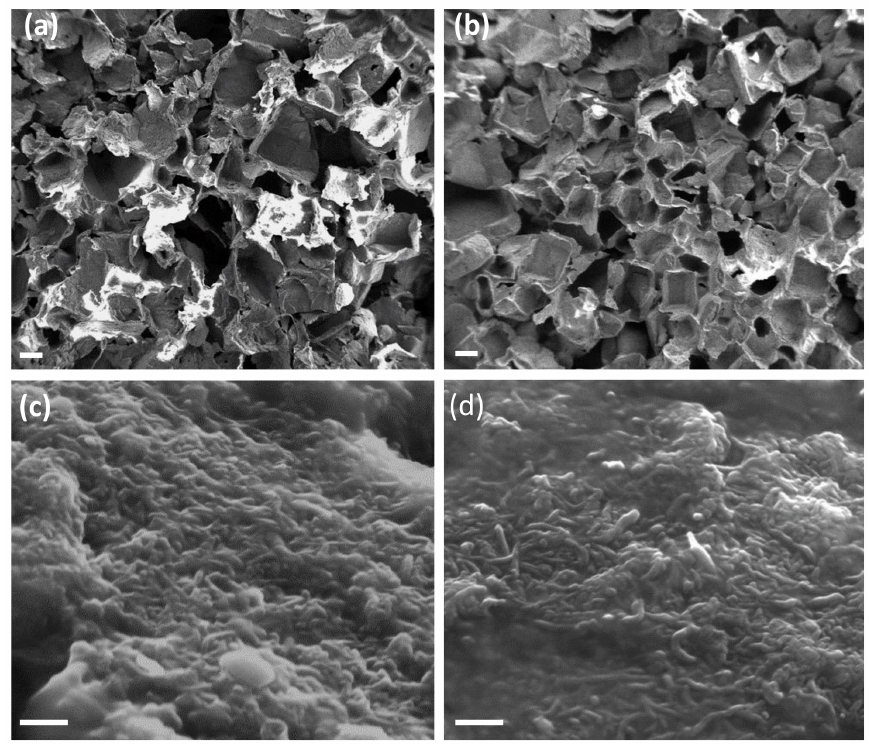
Figure 3. SEM images of PDMS/CNTs long ( a , c ) and PDMS/CNTs short ( b , d ) foams. The scale bar is 200 µ m in ( a , b ) and 200 nm in ( c , d